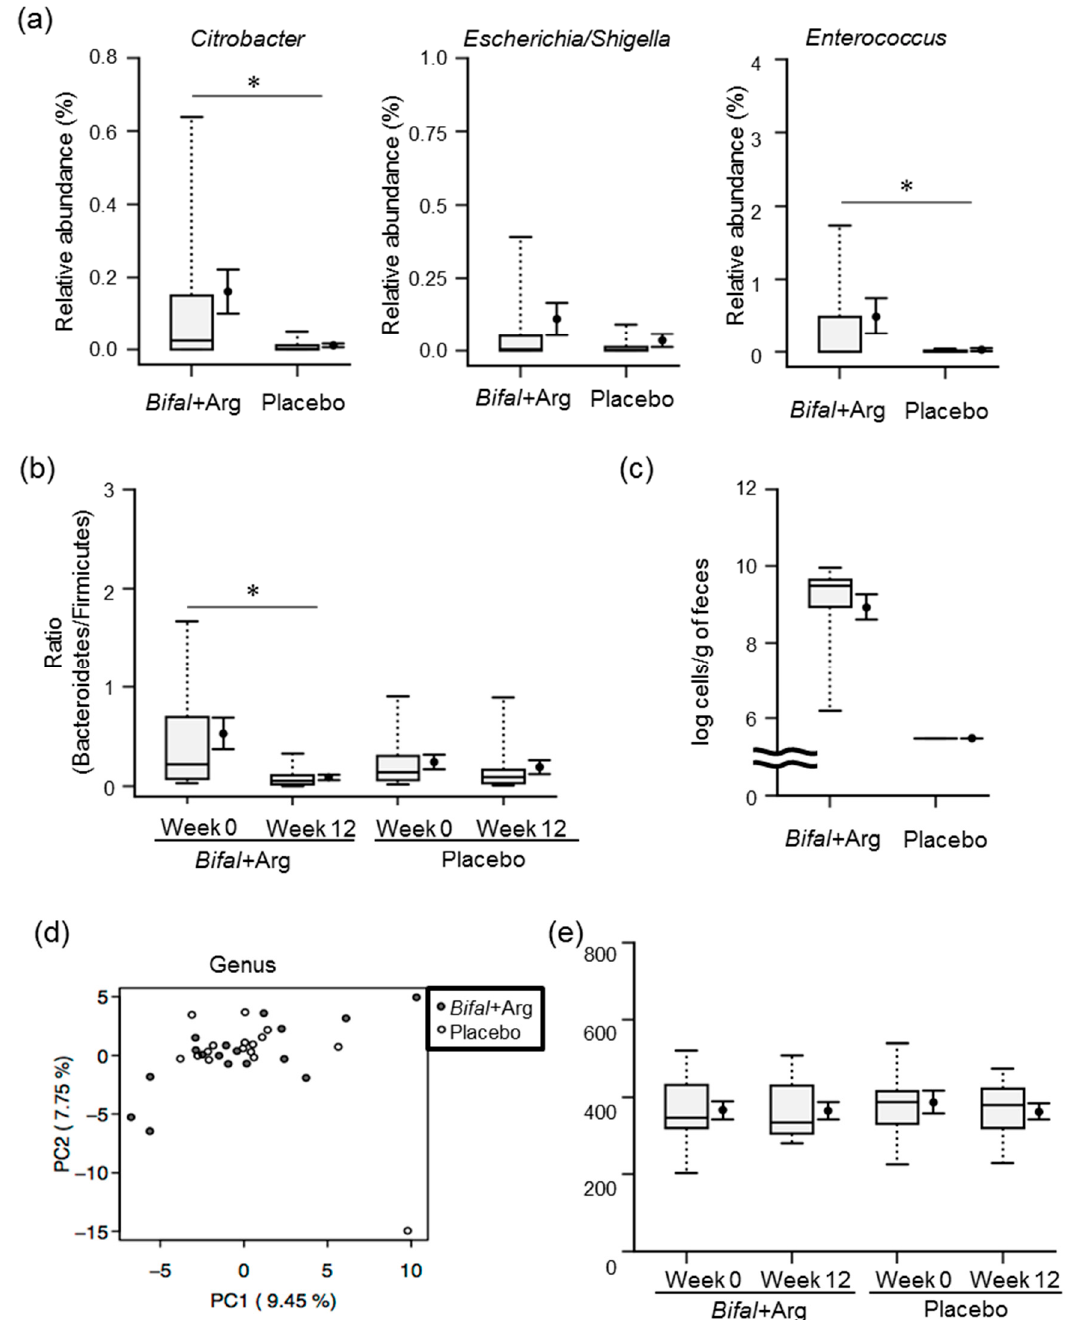
Figure 5. E ff ect of the consumption of yogurt containing B. animalis subsp. lactis and Arg (Bifal + Arg YG) on fecal microbiota. Boxplots represent the 5th percentile, 95th percentile, interquartile range (25–75%), and median. The black circle and error bars on the side of the boxplots represent the average value and SEM, respectively. n = 17 in the Bifal + Arg YG group and n = 16 in the placebo group. One subject in the Bifal + Arg YG group did not submit feces; therefore, it was regarded as a missing value. ( a ) Relative abundance of Citrobacter , Escherichia / Shigella , and Enterococcus in feces. * p < 0.05, Mann–Whitney U test. ( b ) Bacteroidetes:Firmicutes ratio in feces. * p < 0.05, Wilcoxon’s signed rank test. For the nonparametric data, paired t -test using log-transformed values was also performed; the di ff erences were confirmed to be significant (* p < 0.05). ( c ) Number of B. animalis subsp. lactis in feces at week 12. B. animalis subsp. lactis was not detected in the feces of the placebo group (detection limit: 3.0 × 10 5 cells / g of feces). ( d ) Principal component analysis of the fecal microbiota at week 12 (genus level). ( e ) Diversity analysis (chao 1) of fecal microbiota at week 12 (genus level).